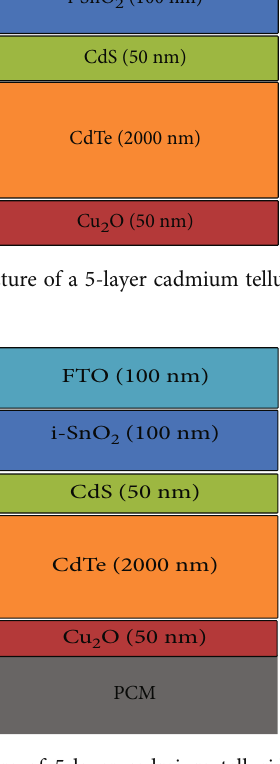
Figure 3: Structure of 5-layer cadmium telluride solar cell with phase change material.